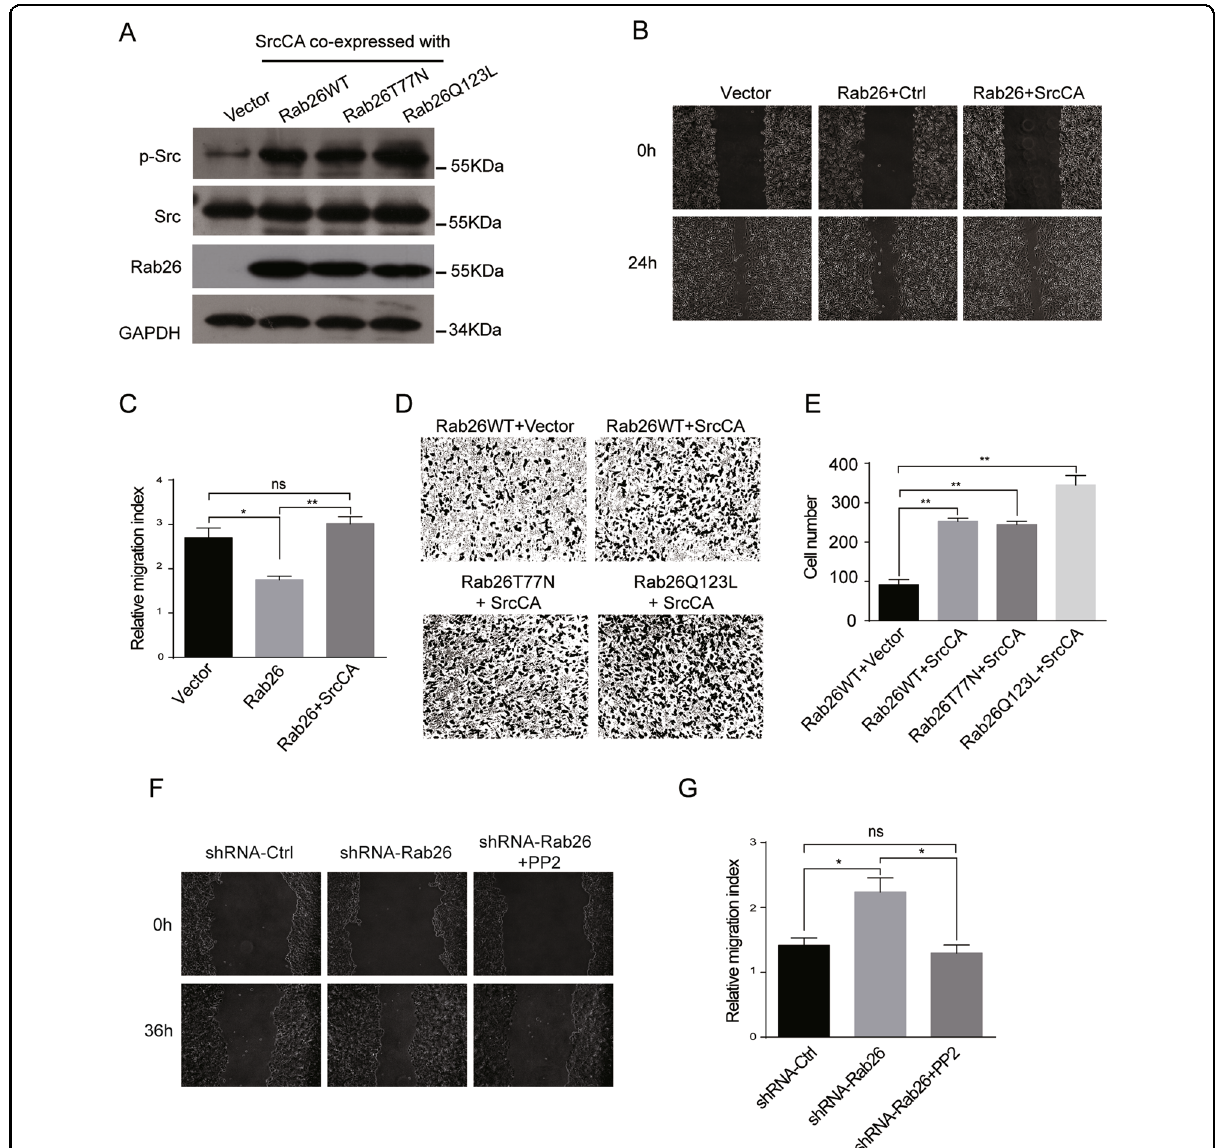
Fig. 5 Expression of the active Src reverses the Rab26-induced inhibition for cell migration and invasion. A MDA-MB-231 cells stably expressing Rab26 were transfected with pUSEamp-SrcCA, western blot showing the expression of SrcCA. B Wound-healing assays showed SrcCA rescued migration of MDA-MB-231 cells expressing Rab26. C Quantitative analysis of the wound area using imageJ software from three independent wound-healing experiments, ** p < 0.01, * p < 0.05. D , E Matrigel invasion assays showed SrcCA promotes invasion of MDA-MB-231 cells expressing Rab26. ** p < 0.01. F Wound-healing assays showed inhibition of Src activity by PP2 inhibits migration of MCF7 cells with Rab26 depleted. G Quantitative analysis of the wound area using imageJ software from three independent wound-healing experiments, * p <